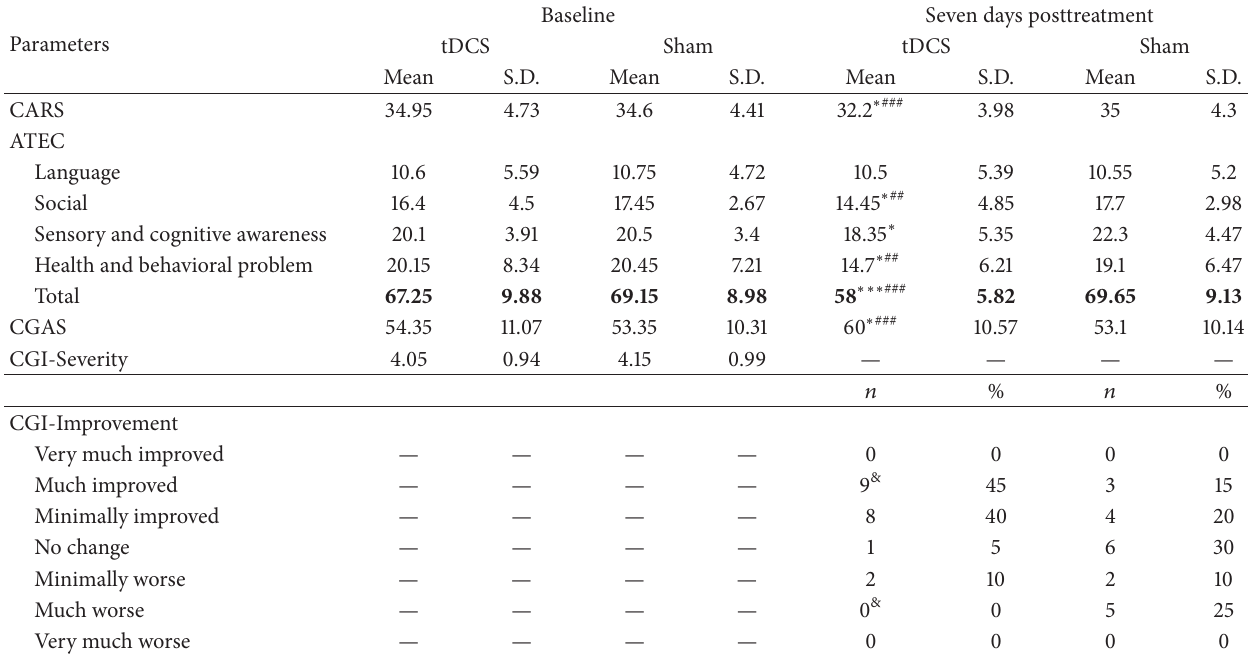
Table 2: Childhood Autism Rating Scale (CARS), Autism Treatment Evaluation Checklist (ATEC) scale, Children’s Global Assessment